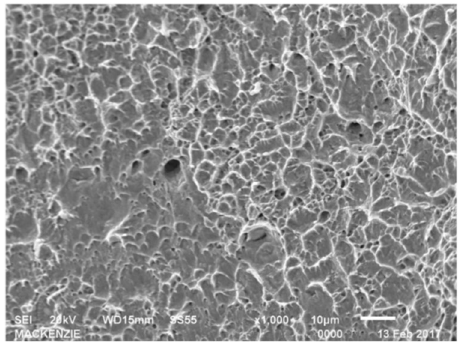
Figure 9. Micrographs of the Inconel 625 fracture surface tensile tested at 700 °C showing transgranular cracking with tear dimples.